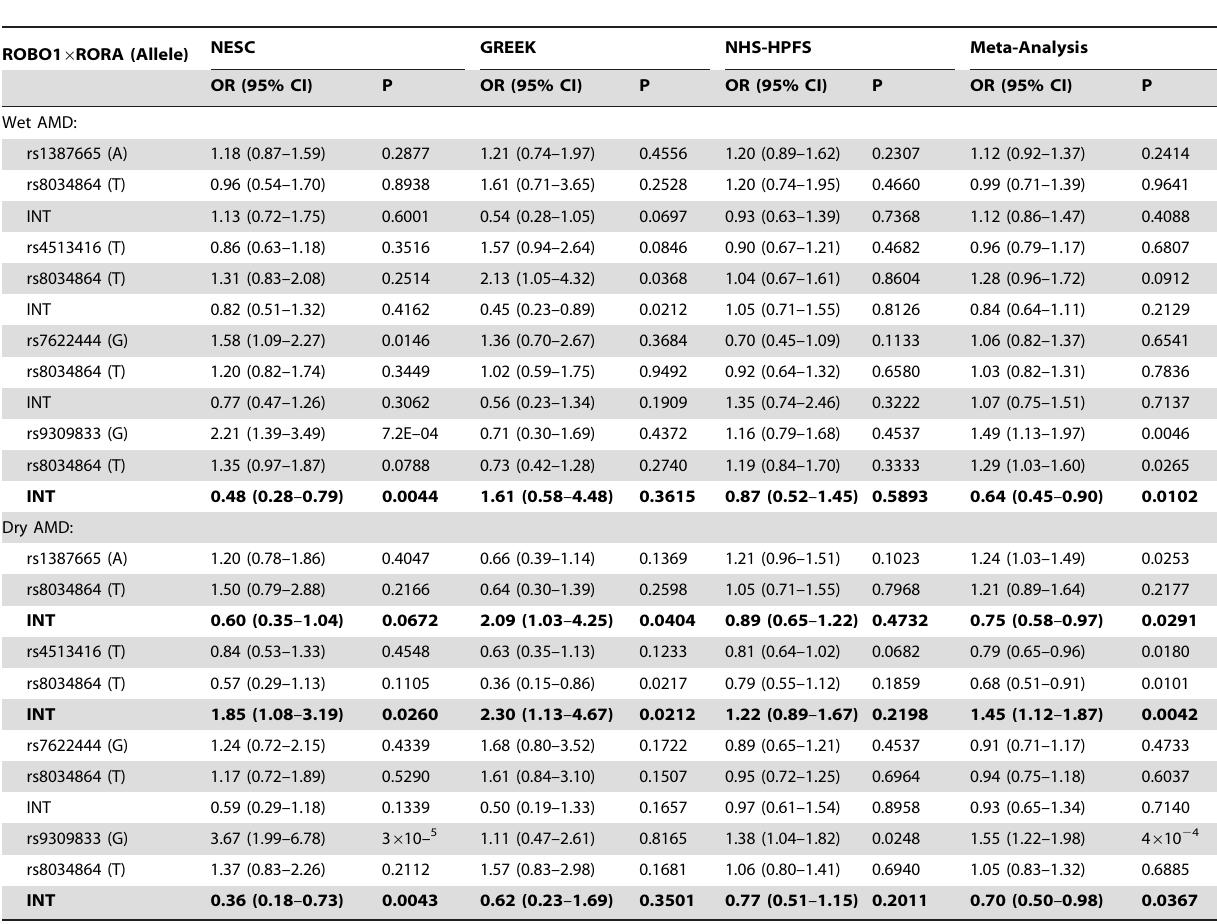
Table 6. Summary of interaction analysis of ROBO1 SNPs (rs4513416, rs7640053, rs7622444 and rs9309833) and a RORA SNP (rs8034864) for wet and dry AMD in the three cohorts, NESC, GREEK, NHS-HPFS, and in meta-analysis.